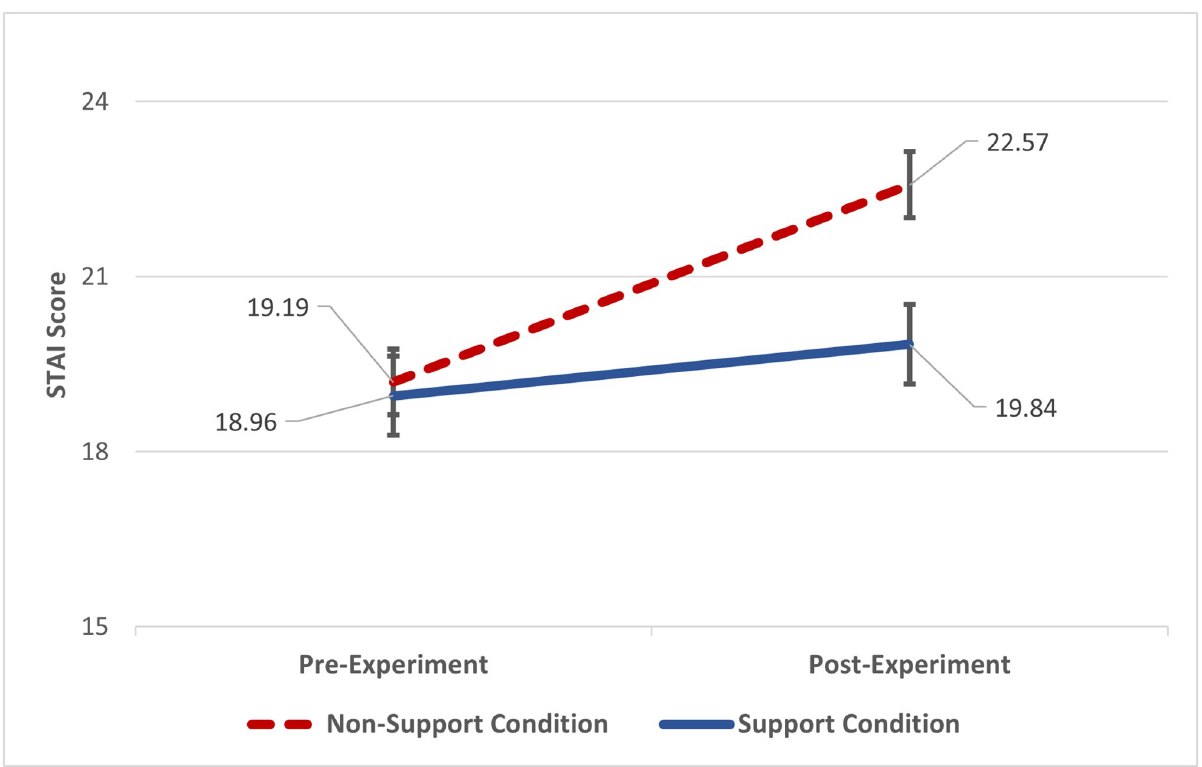
Fig 2. Interaction of Spielberger State-Trait Anxiety Inventory (STAI) and Spouse Condition. Note . Graph shows the interaction of participants’ self-reported pre anxiety and post anxiety scores and Spouse Condition. There were no differences in pre anxiety scores between the two conditions, but those in the non-support condition indicated higher feelings of anxiety post experiment compared to those who had their spouse hold their hand during the experiment. STAI scale ranges from 13–52, higher scores indicating higher anxiety. https://doi.org/10.1371/journal.pone.0256823.g002 Tonic analysis. We analyzed tonic pupil size, defined as overall differences in pupil diam- eter during each of the video clips. Pupil sizes were analyzed as a function of Video Clip (Neu- tral vs. Horror), Spouse Condition (Non-Support vs. Support), and Relationship Quality (Ambivalent vs. Supportive). These variables were dummy coded, with baseline values being Table 3. Blood pressure, self-report, and pupil diameter correlations.